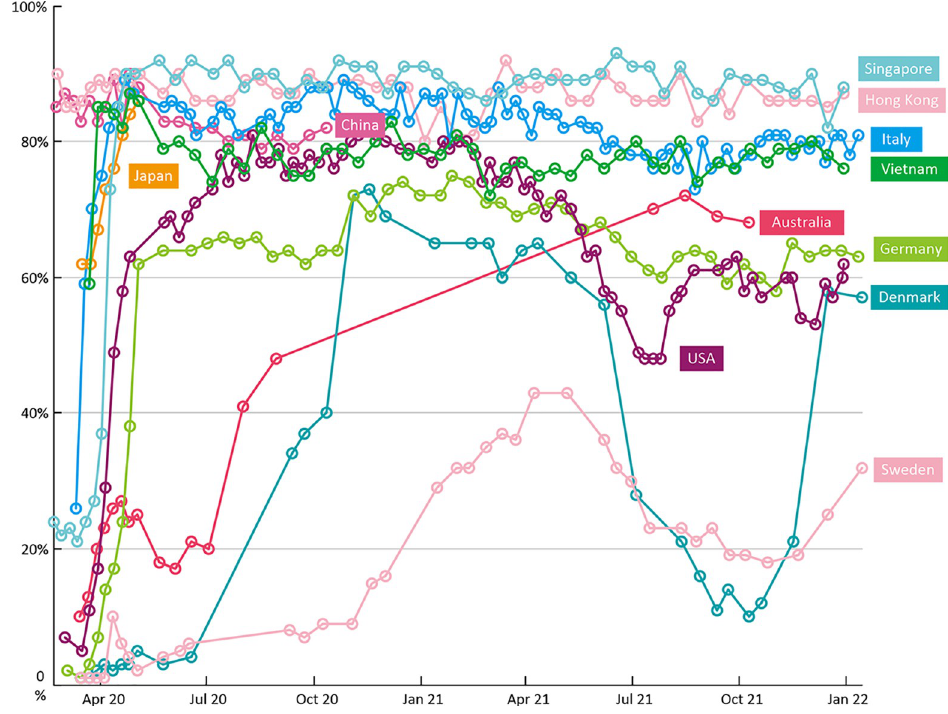
Fig 2. Face mask wearing in different populations. Source: https://yougov.co.uk/topics/international/articles- reports/2020/03/17/personal-measures-taken-avoid-covid-19.